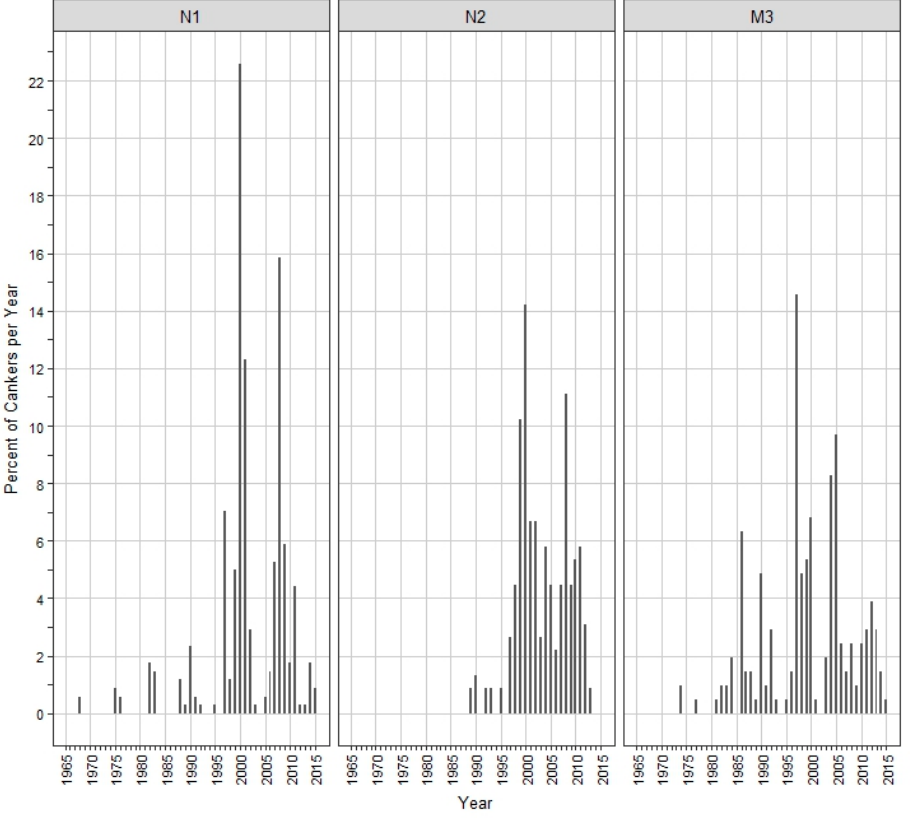
Figure 3. Canker history in each of three sampled stands: N1, N2, and M3. The vertical bars represent the percent of total cankers at each site that occurred in a given year.